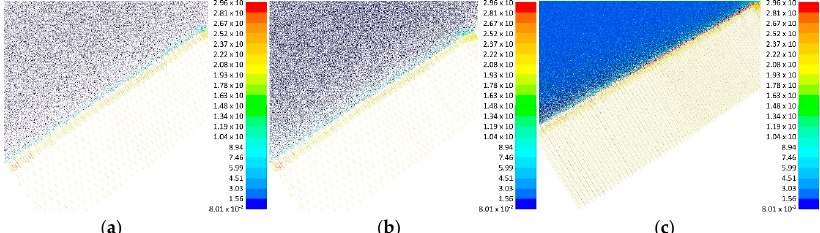
Figure 14. Velocity field for longitudinal crack at P = 5.0 bar and Q in = ( a ) 10 L/s, ( b ) 20 L/s, ( c ) 30 L/s.